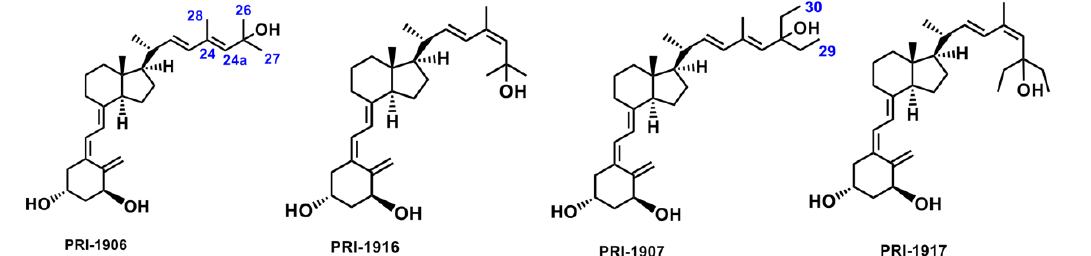
Figure 3. Structural formulas of the analogs of 1 α ,25-dihydroxyvitamin D 2 (PRI-1906, PRI-1907, PRI-1916, and PRI-1917).